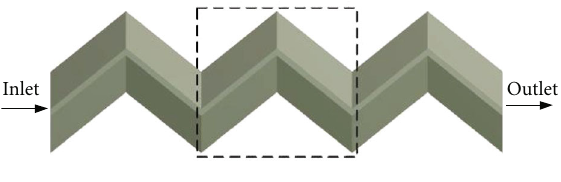
Figure 6: Schematic of a three-unit